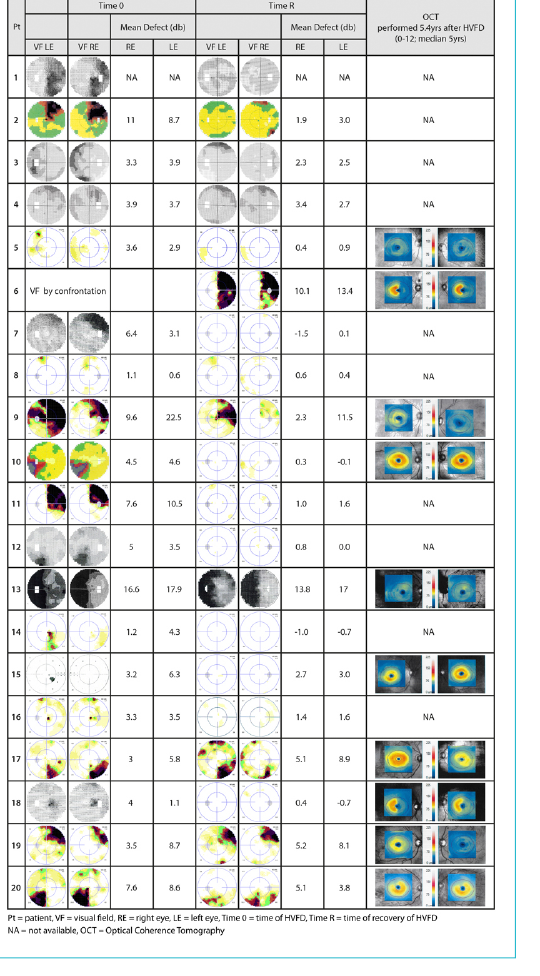
Figure 1: Visual field and optical coherence tomography findings in multiple sclerosis patients with homonymous visual field defects.